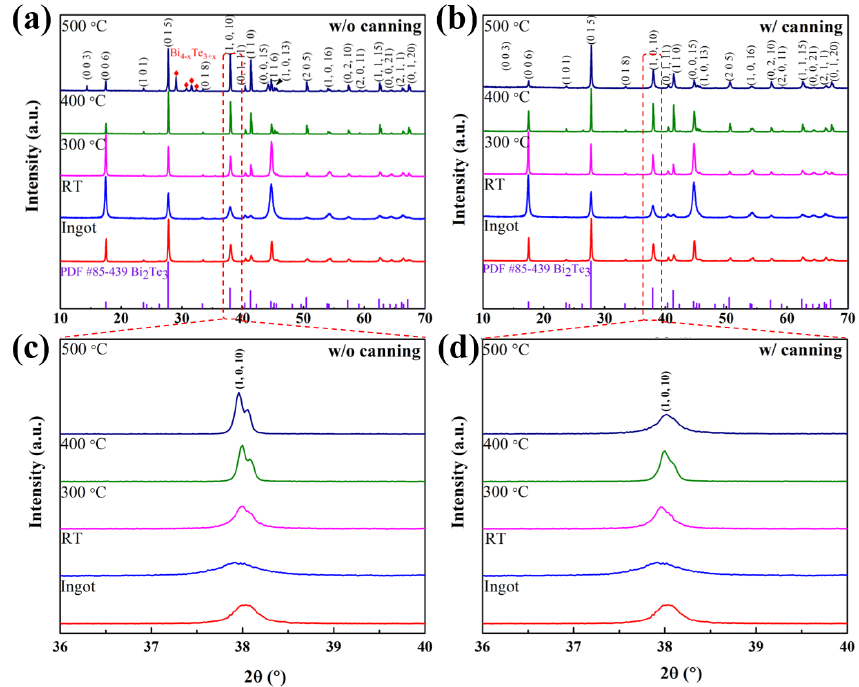
Figure 2. XRD patterns of ingot, Bi 2 Te 3 pellet prepared at RT, and pellets annealed at various temperatures (300, 400, and 500 ◦ C) ( a ) without and ( b ) with coin cell canning package; magnified view of peaks at (1 0 10) ( c ) without and ( d ) with canning package accompanied by peak